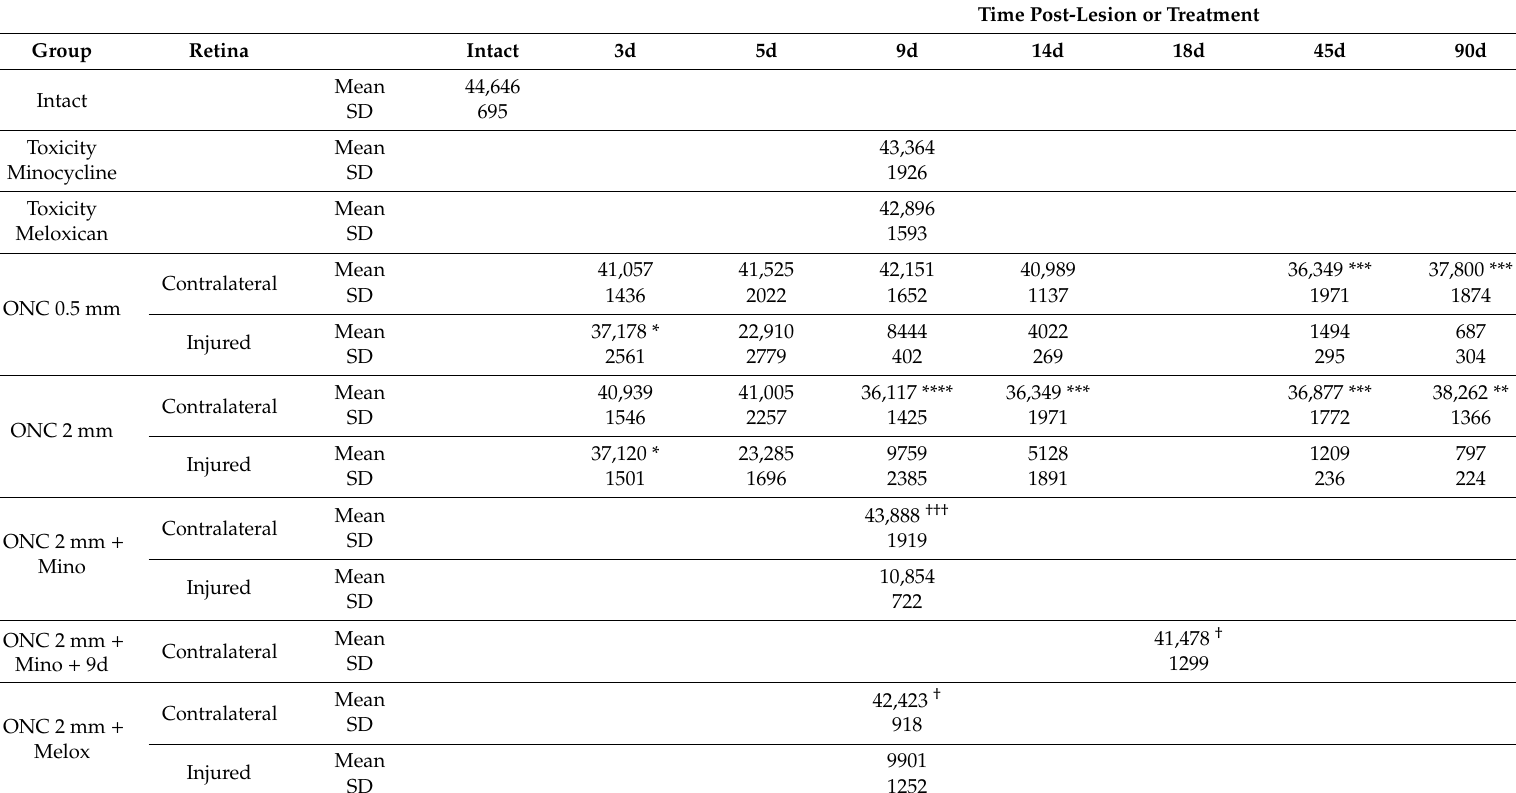
Table 1. Total number of RGCs. Mean number ± standard deviation (SD) of the total population of RGCs quantified in the injured and contralateral retinas from each group and time point. In the injured retinas, RGC death was first significant at day 3 after either lesion. In the contralateral un-injured retinas, RGC death was significant at day 9 in the ONC 2 mm group, and at day 45 in the ONC 0.5 mm group. Minocycline or meloxicam treatment for 9 days did not a ff ect the population of RGCs in non-injured animals (toxicity assays), but rescued RGCs in the contralateral retinas (ONC 2 mm + Mino (minocycline), ONC 2 mm + Melox (meloxicam)). This rescue was maintained 9 days after ending minocycline administration (ONC 2mm + Mino + 9d). In the injured retinas, neither treatment had an e ff ect on RGC